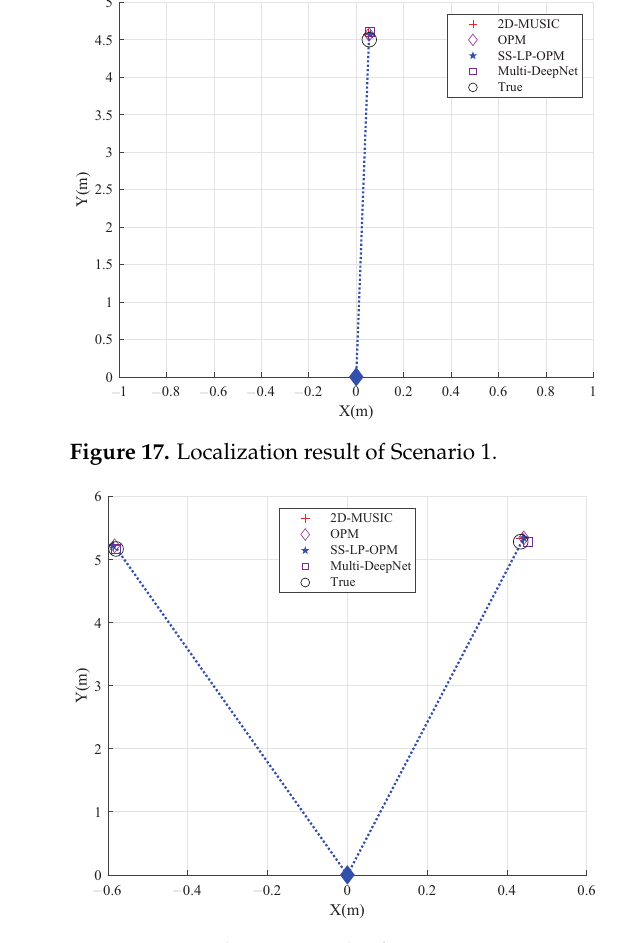
Figure 18. Localization result of Scenario